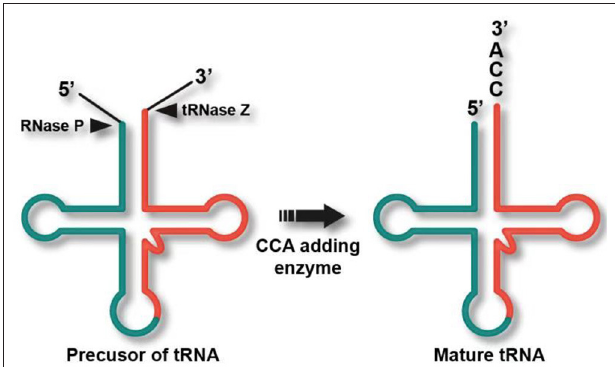
FIGURE 2 | Post-transcriptional processing of a typical intron containing tRNA transcript. RNase P processes the 5 ′ end, tRNase Z processes the 3 ′ end, CCAse adds the CCA tail to the 3 ′ end after 3 ′ endonuclease catalysis, and aaRS adds amino acids to the end of CCA, thereby generating the mature mitochondrial tRNA (Levinger et al.,